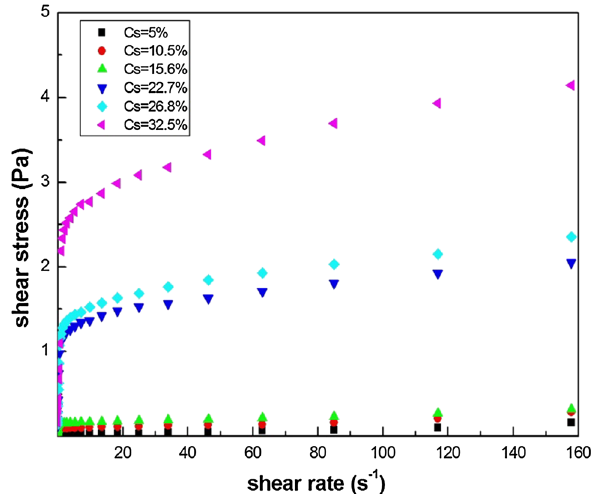
Fig. 6 Shear stress as a function of shear rate at different solids con- centrations